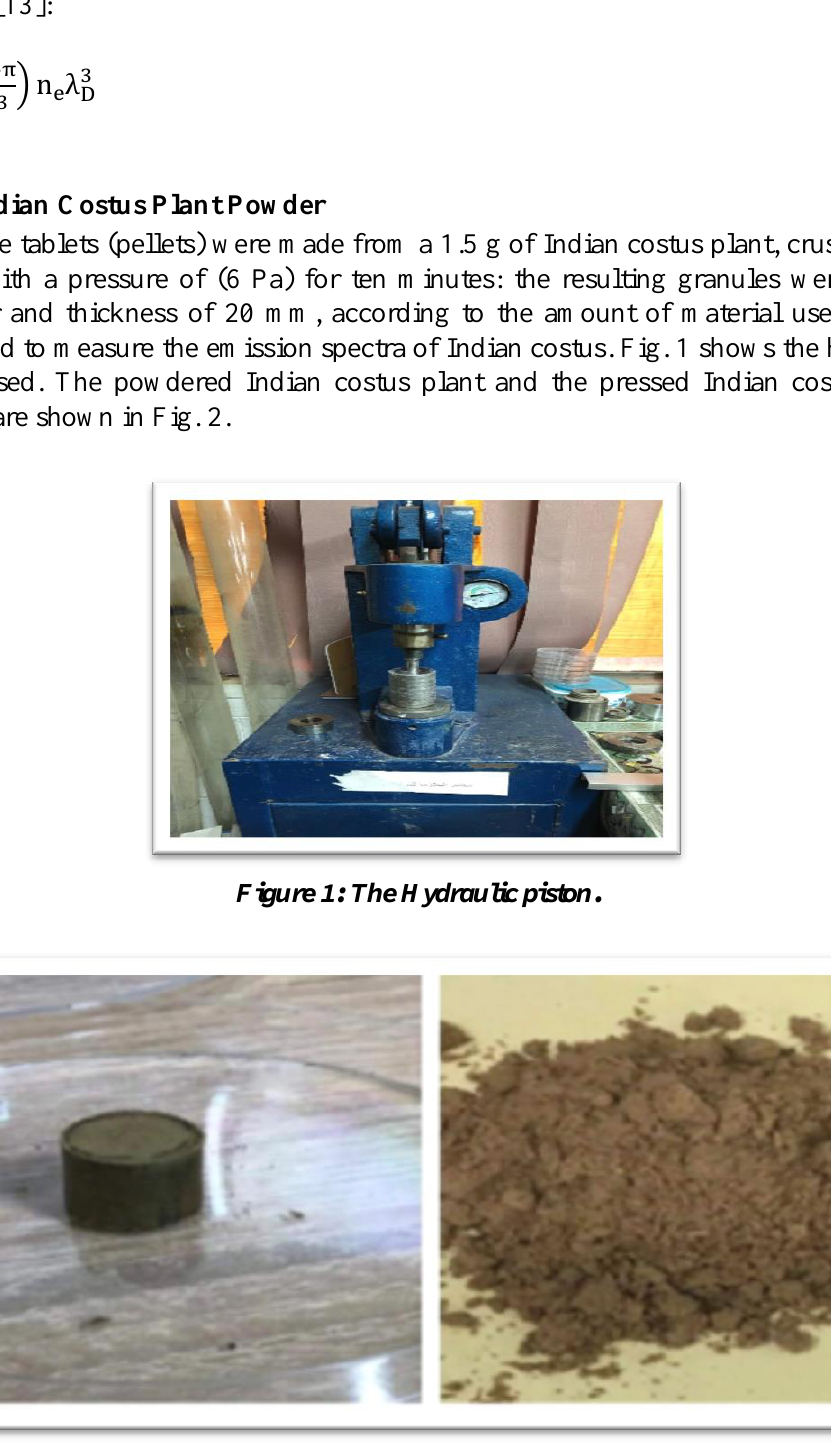
Figure 2: The Indian Costus plant powder and its